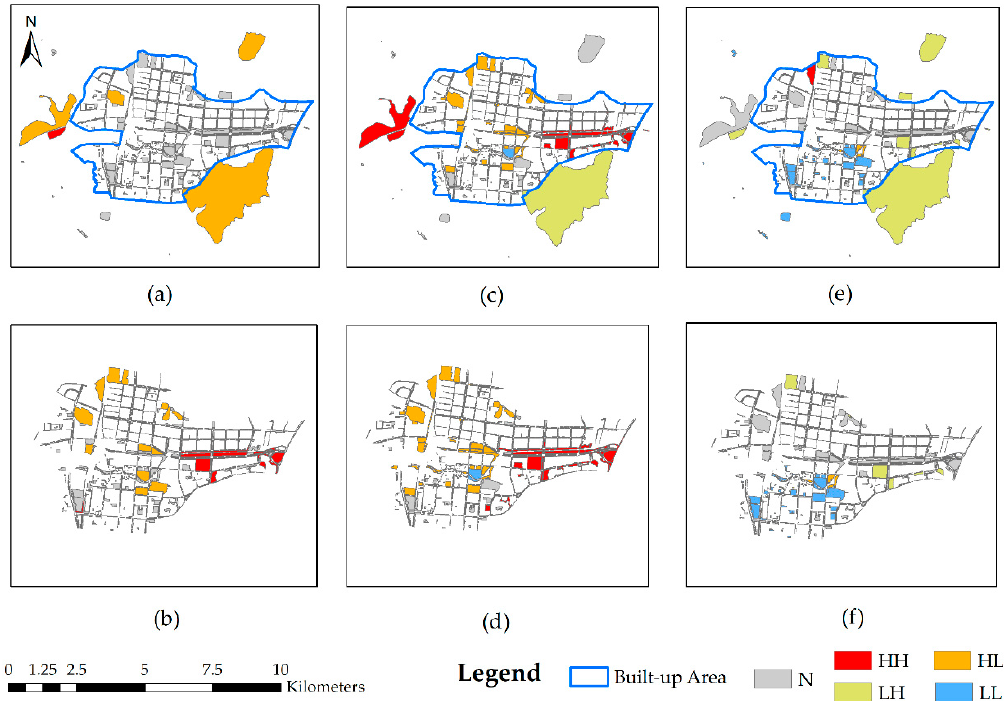
Figure 5. Local autocorrelation analysis results of public open spaces on: ( a ) area in whole area, ( b ) area in built-up area, ( c ) length in whole area, ( d ) length in built-up area, ( e ) type in whole area, ( f ) type in built-up area.